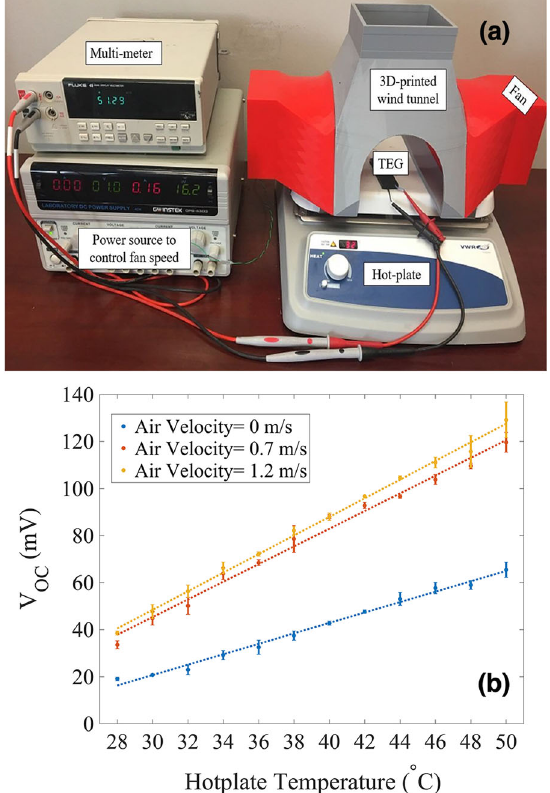
Fig. 5 Impact of hot-plate temperature and air velocity on TEG open-circuit voltage. a Measurement setup consisting a wind tunnel placed on a hot-plate. b The dependence of the open-circuit voltage on hot-plate temperature and air velocity. Error bars indicate standard